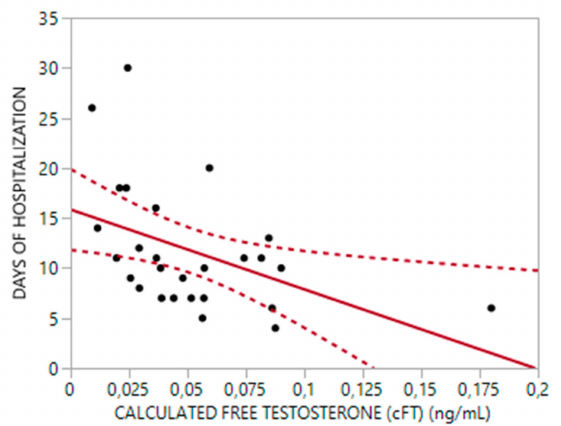
Figure 2. Relationship between calculated Free Testosterone (cFT) and Hospitalization time (R 2 = 0.2, p : 0.018).